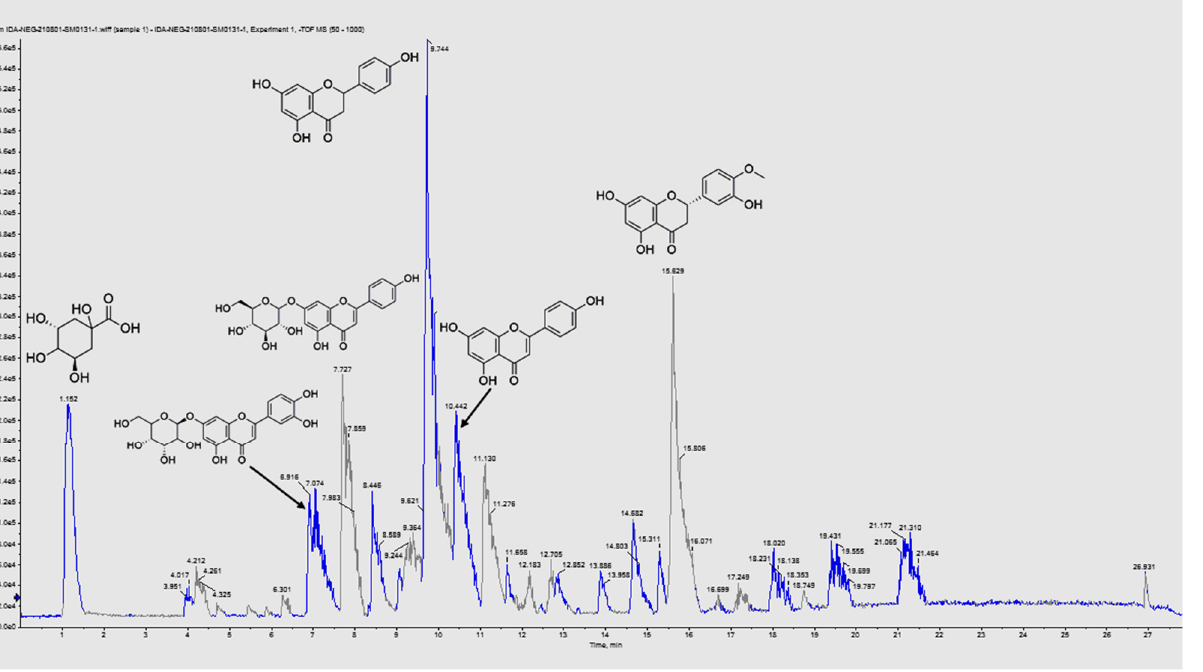
Figure 1. The total ion chromatogram of EVME presented the major identified metabolites (D-( − )- quinic acid, luteolin-7- O -glucoside, apigenin-7- O -glucoside, naringenin, apigenin, and hesperetin according to the retention time) via LC–ESI–MS/MS in negative ion mode .